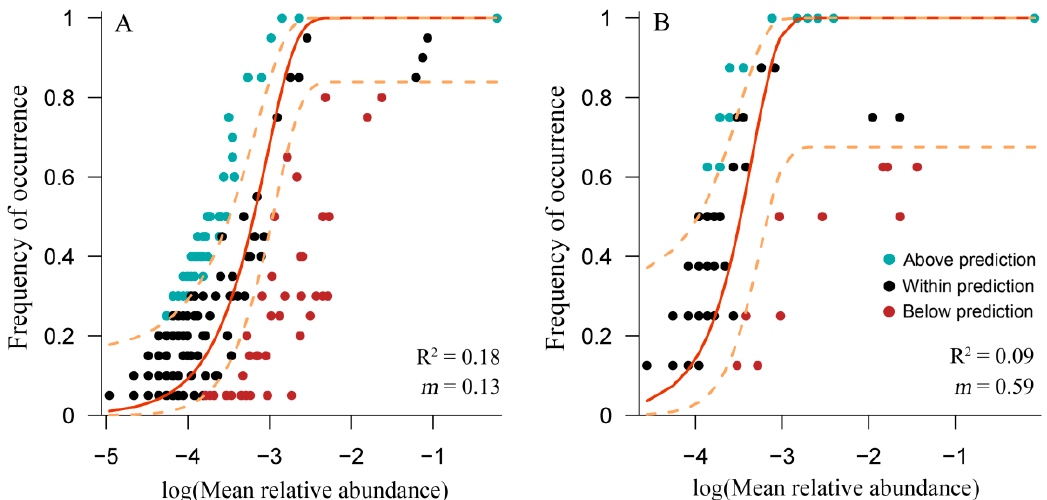
Figure 4. Neutral model simulation of cyanobacterial communities from Erhai Lake ( A ) and Lushui Reservoir ( B ). The solid lines indicate the best-fit theoretical description of the OTU assembly for each water body. Dashed lines represent the 95% confidence intervals for the model prediction.